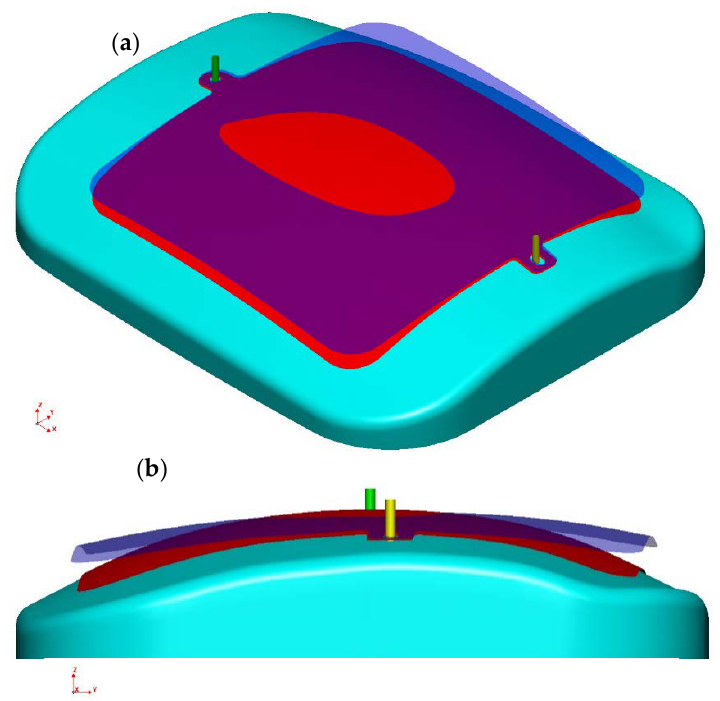
Figure 6. ( a ) Isometric view and ( b ) YZ view, of hydroformed Part 1, before springback (red blank) and after springback (blue